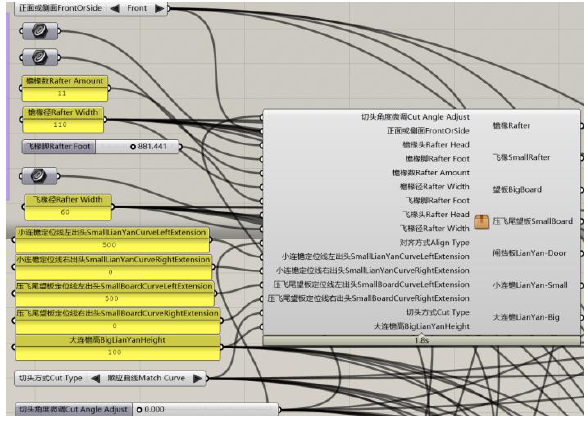
Figure 21. The binary cluster (generators) of rafters and accessories